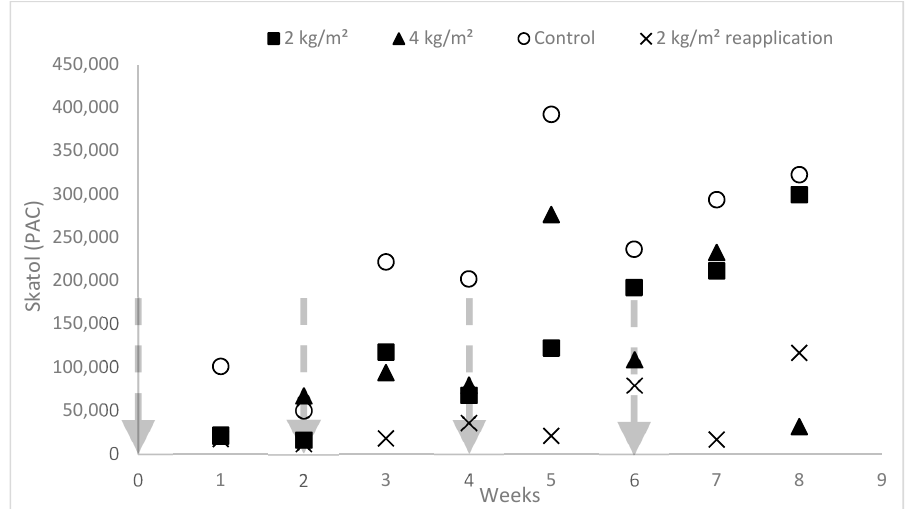
Figure 2. Mitigation of skatole emissions from swine manure treated with biochar—effects of one-time dose (2 and 4 kg/m 2 ) and 2 kg/m 2 bi-weekly reapplication. Vertical arrows represent the application or reapplication of biochar and manure to storage simulators. Each data point represents the mean of ( n = 3) measurements. Detailed statistical analysis is provided in Table S2. A surrogate abundance of indole is represented by (PAC), i.e., peak area counts for indole in the headspace above manure measured by SPME and analyzed by GC-MS. PACs are arbitrary units of M.S. detector